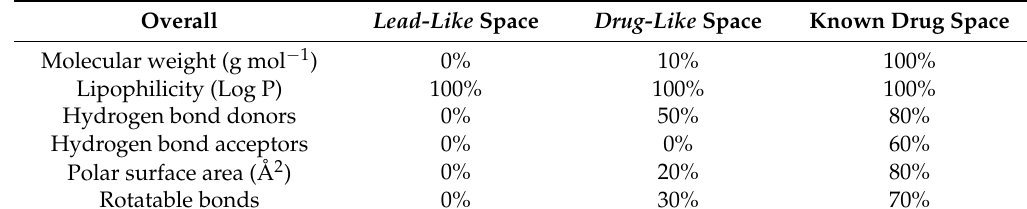
Table 6. CLCs studied within the defined chemical spaces.